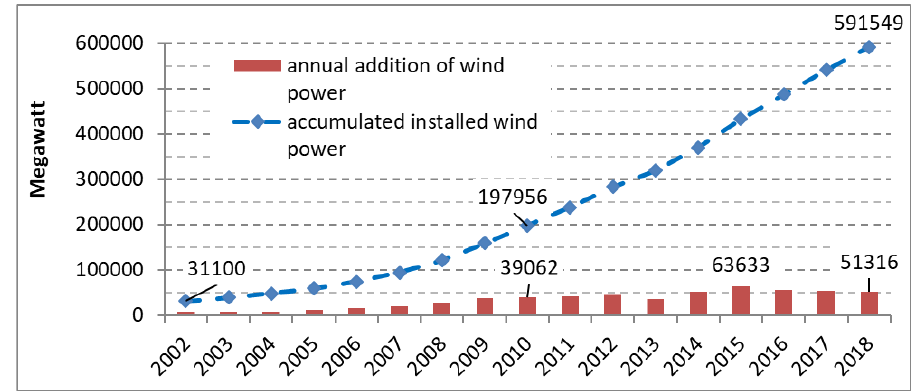
Figure 1. Worldwide cumulative installed wind energy output and annual output increase (in megawatts) from 2002–2018 [4], own illustration.